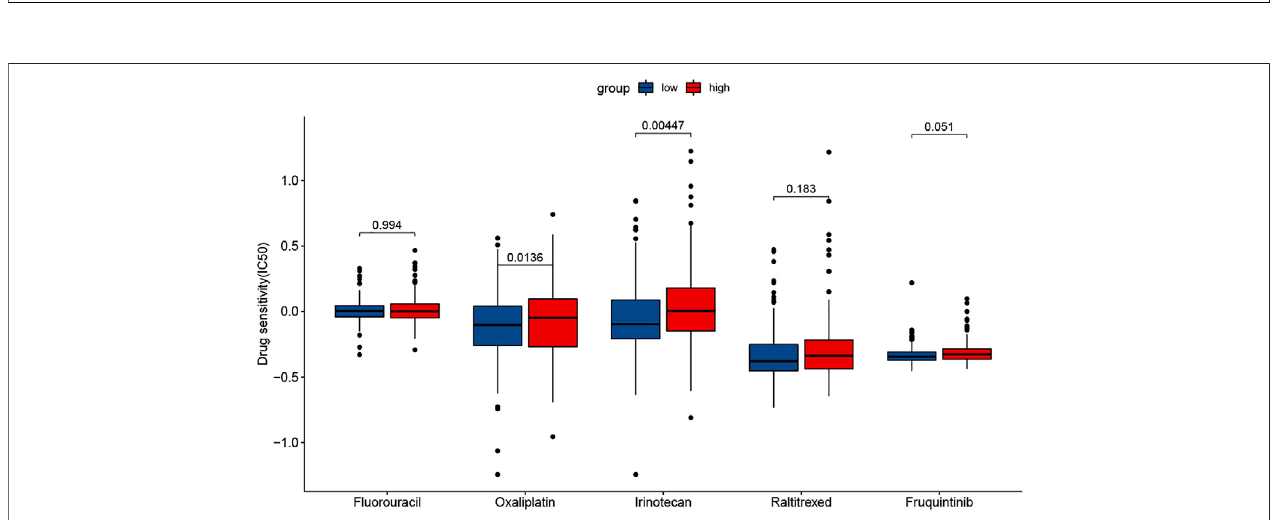
FIGURE 10 | Prediction of drug sensitivity in the therapy of colorectal cancer.